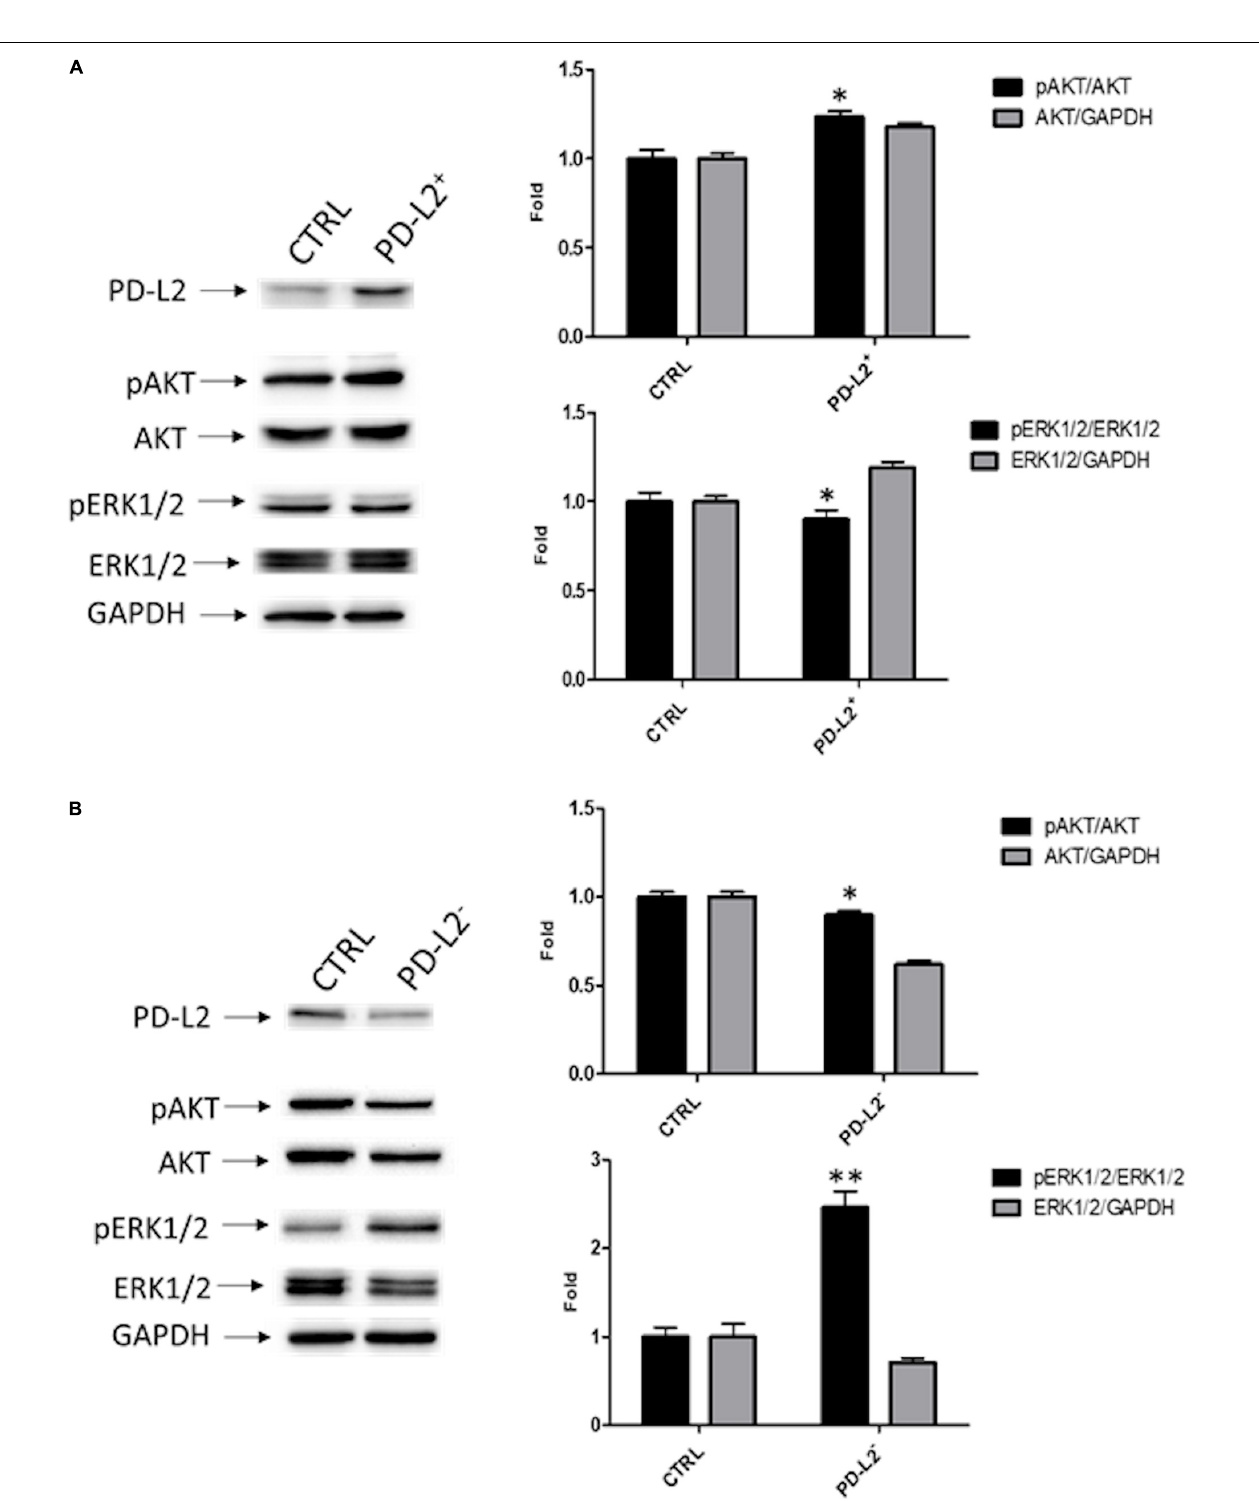
FIGURE 7 | PD-L2 influences AKT and ERK pathways. (A) Western blot analysis of pAKT (Ser473), pERK1/2(Thr202/Tyr204), ERK1/2, AKT, and GAPDH protein levels in PD-L2 + EC cells. (B) Western blot analysis of pAKT (Ser473), pERK1/2(Thr202/Tyr204), ERK1/2, AKT, and GAPDH protein levels in PD-L2 − EC cells. Blots are representative of one of three separate experiments. The pERK1/2(Thr202/Tyr204) and pAKT (Ser473) protein levels were determined with respect to ERK1/2 and AKT levels. ERK1/2 and AKT densitometry values were normalized to GAPDH used as loading control. Densitometric values shown are the mean ± SE of three separate experiments. * p < 0.05 vs control